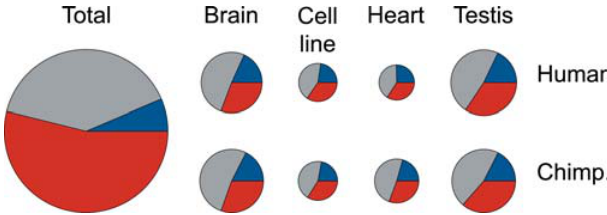
Figure 2. Distribution of Expressed Probes among Exons, Introns, and Intergenic Regions The distributions of expressed probes among exonic (blue), intronic (gray), and intergenic (red) regions in four tissues in humans and chimpanzees. The size of the circles reflects the number of probes (Table S2). All distributions represent an average of the two DNA strands, measured independently. There were no identifiable differences between expressed probe distributions on the two strands (Figure S2). ‘‘ Total ’’ indicates the distribution of all array probes, irrespective of their expression levels. DOI: 10.1371/journal.pgen.0020171.g002